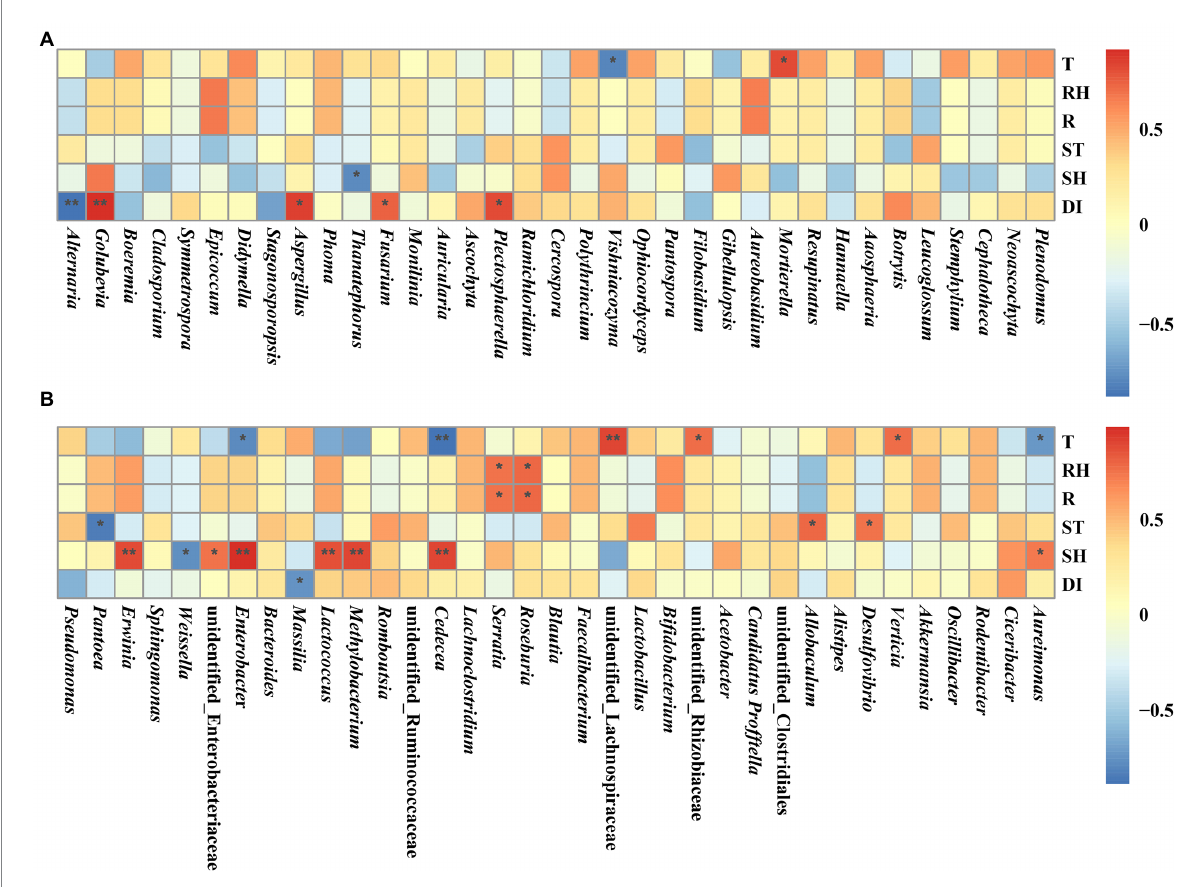
FIGURE 10 Spearman correlation analysis between microbial communities and environmental factors in tobacco leaves at four sampling time points. (A) For fungal communities and (B) for bacterial communities. Temperature (T), relative humidity (RH), rainfall (R), soil temperature (ST), soil relative humidity (SH), and disease index (DI). “*” represents a statistical difference between groups ( p < 0.05), “**” represents a significant statistical difference between groups ( p <